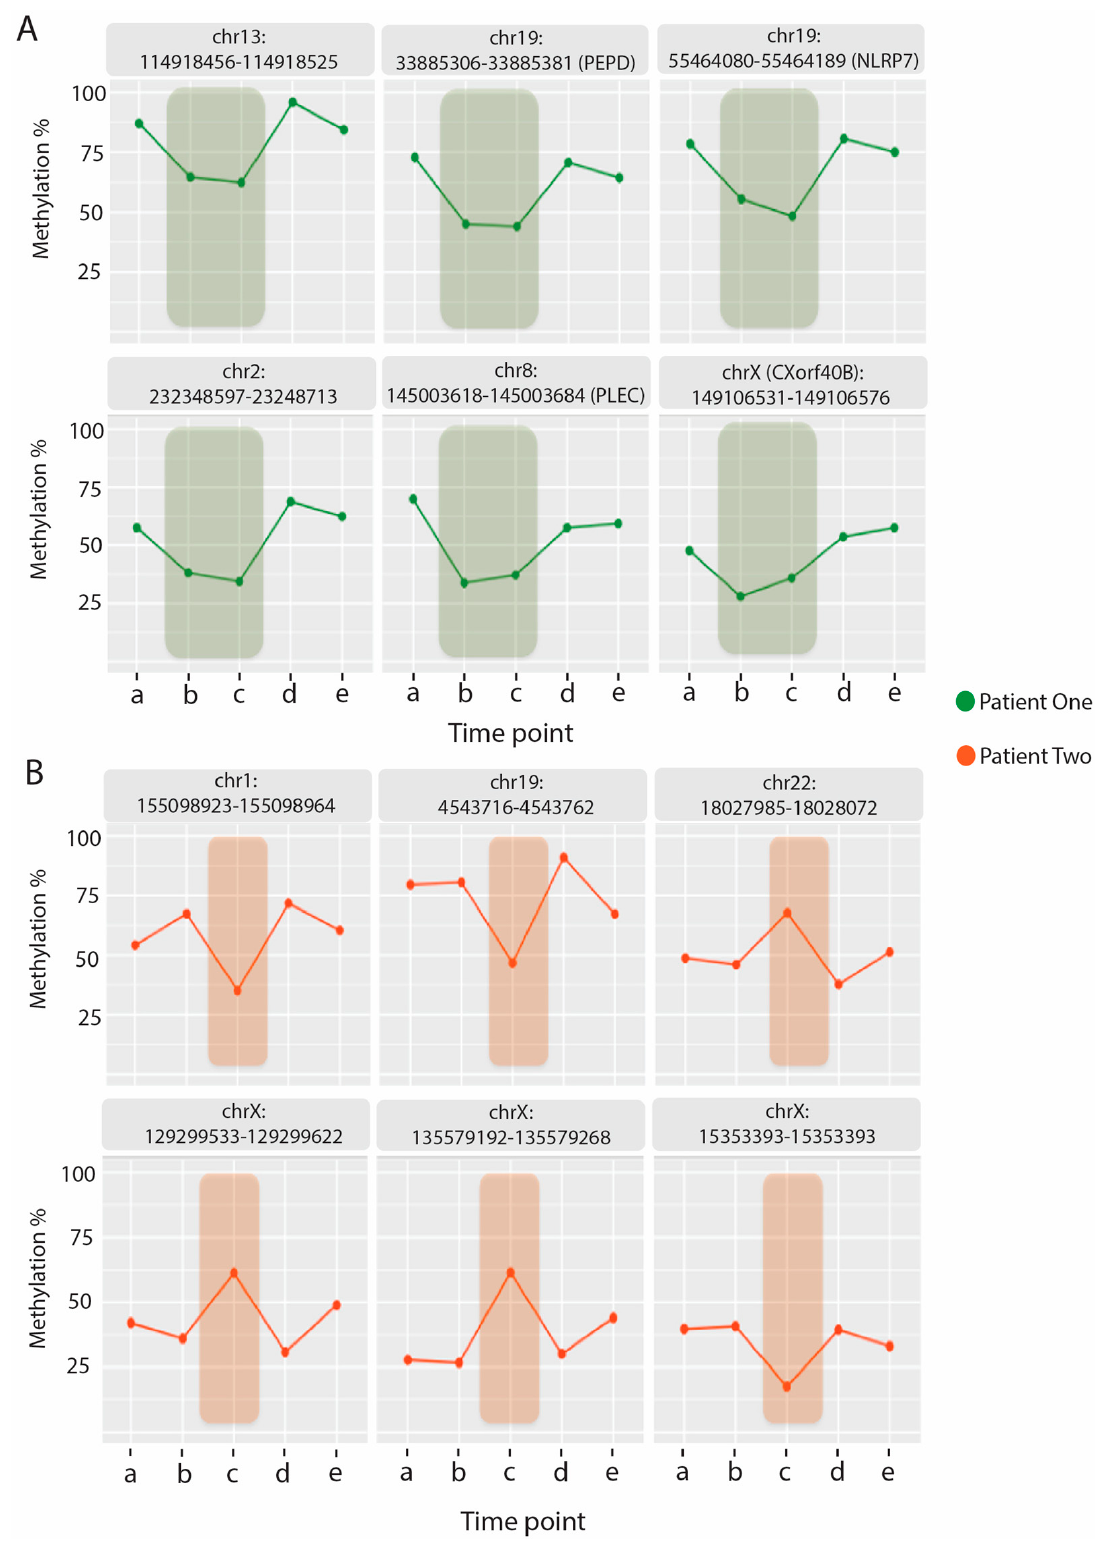
Figure 4. Dynamic DNA methylation variation correlated to self-reported patient health status. Methylation percentages are shown across all five time points a to e for each fragment of interest -fragment co-ordinates are shown above each block and a gene id is shown in brackets if the fragment directly overlaps a gene feature (intron/exon). ( A ) P1-green highlight indicates a period of relapse, ( B ) P2-orange highlight indicates period of relapse captured in one blood sampling.